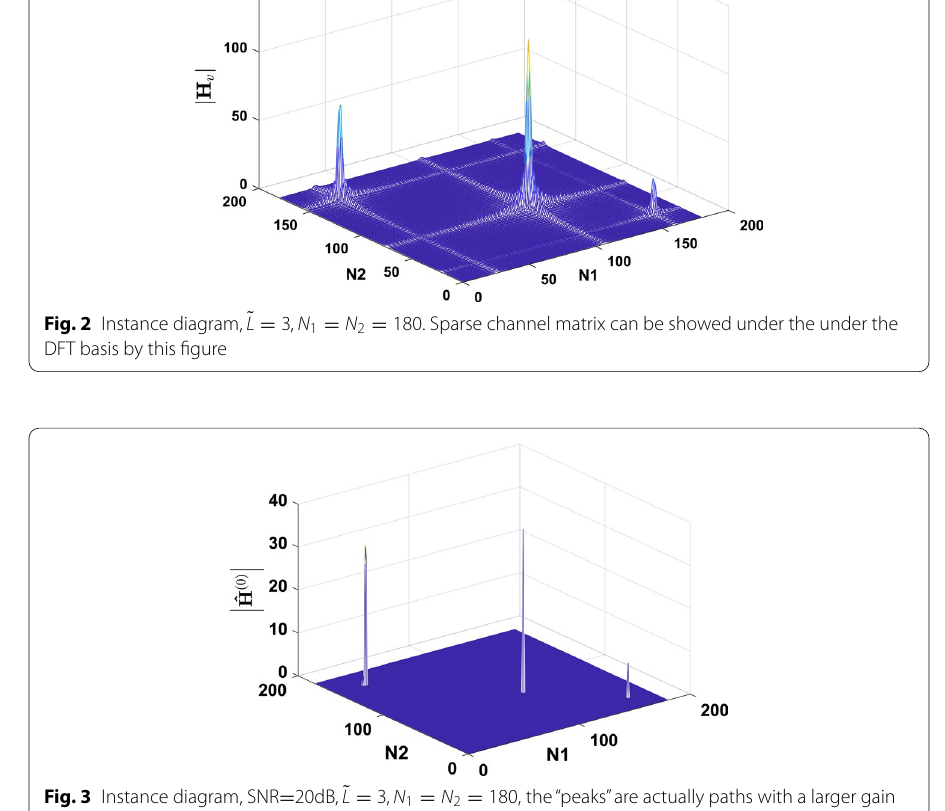
Fig. 3 Instance diagram, SNR 20dB, ˜ L = 3 , N 1 = N 2 = 180 , the “peaks” are actually paths with a larger gain = and the location corresponding to the angle of AoAs and